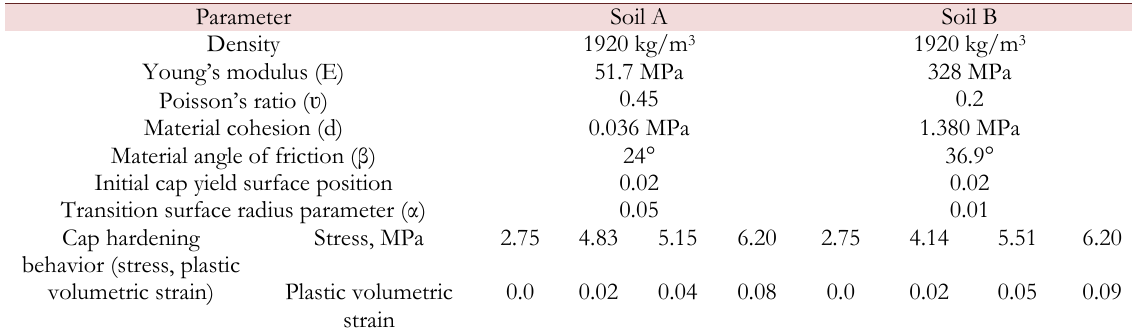
Table 1: Soil properties, selected form [26, 28].